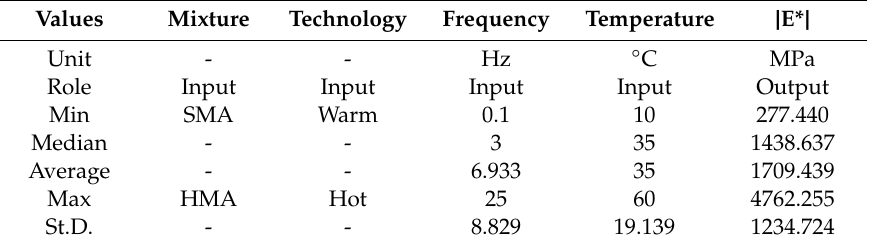
Table 4. Statistical analysis and summary of the input and output variables used in this